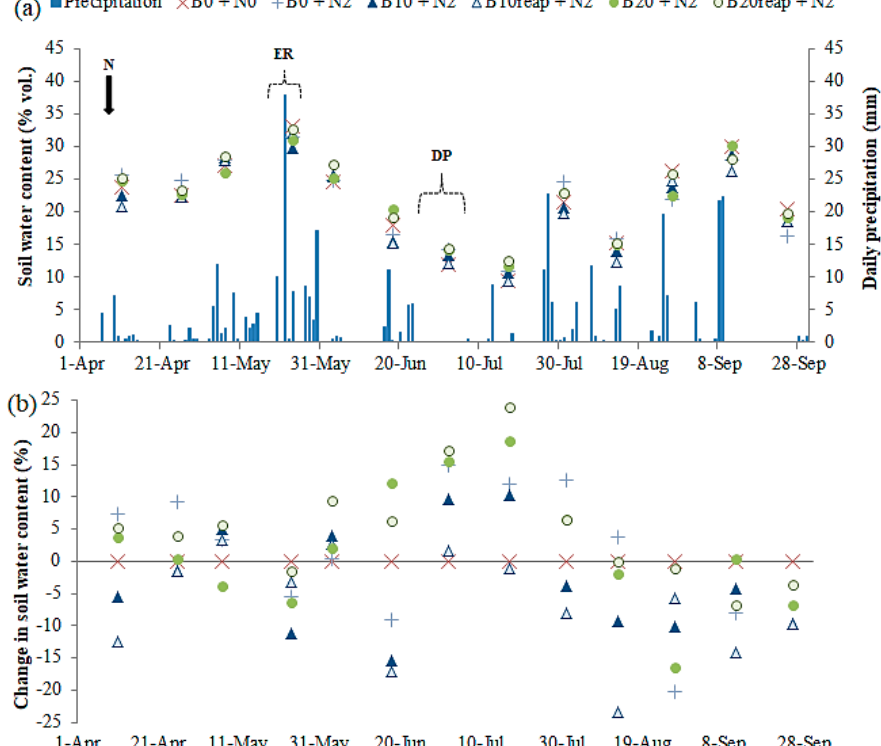
Figure 4. Soil water content dynamics in fertilized treatments N2 during the studied period in 2019: ( a ) soil water content with indication of daily precipitation, N—nitrogen fertilizer application, ER—extreme rainfall, DP—dry period; ( b ) percentage change in soil water content relative to control treatment B0 + N0 (without biochar and N-fertilizer application).